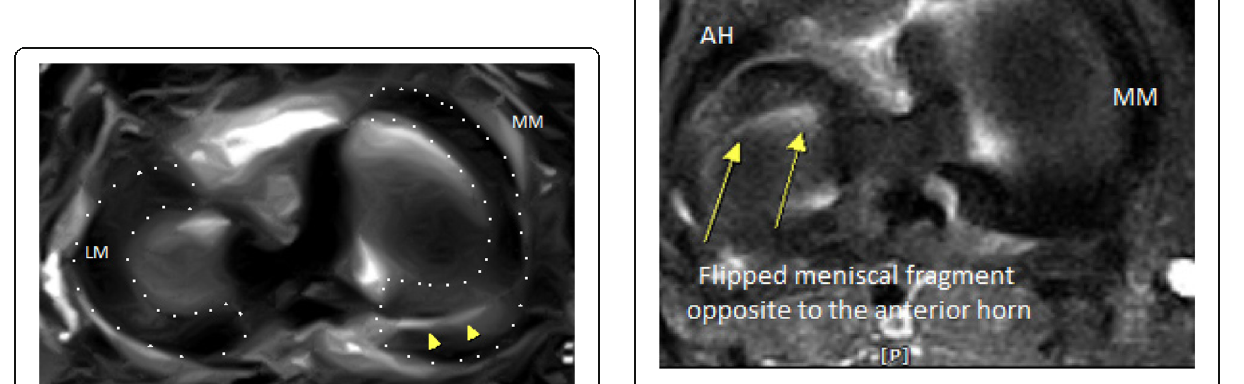
Fig. 8 Displaced bucket handle tear of the lateral meniscus (arrows). Note ventrally flipped meniscal fragment within the lateral femorotibial joint compartment mildly compressing the free meniscal edge of the anterior horn. AH = anterior horn and MM = medial